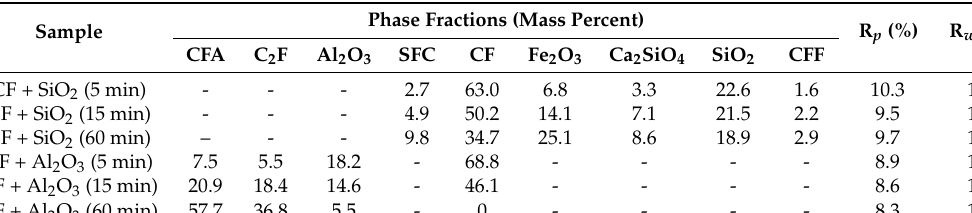
Table 2. Phase fractions of the sintering samples CF + Al 2 O 3 and CF + SiO 2 determined by the Rietveld method.